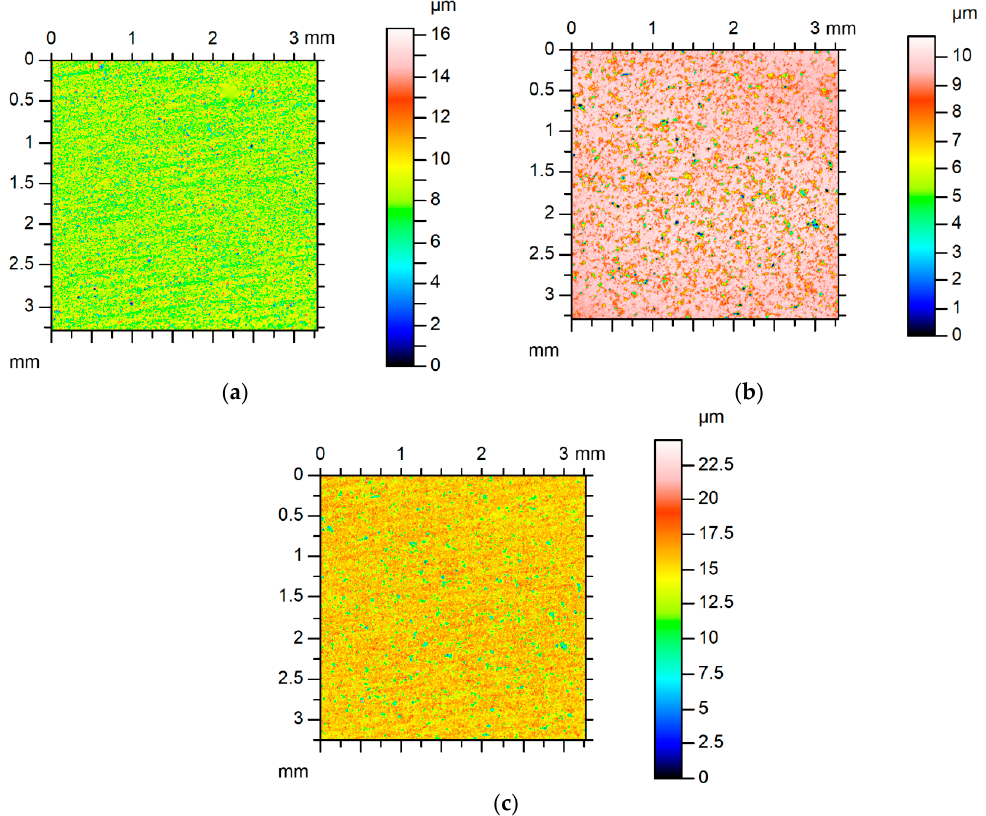
Figure 13. Contour plots of surface G ( a ), of surface H ( b ), and of equivalent sum surface ( c ).